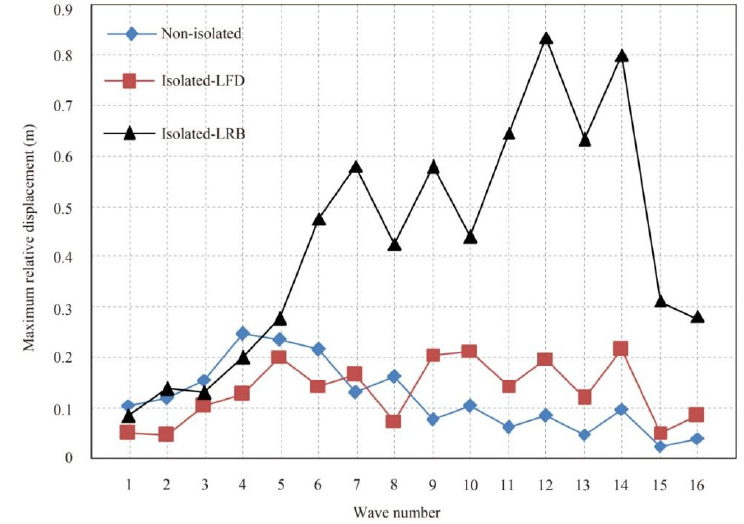
Figure 13. Maximum bearing displacement at pier 4 for the original system (Non-isolated), LFD system (Isolated-LFD), and LRB system (Isolated-LRB) with ground motions in Table 1.